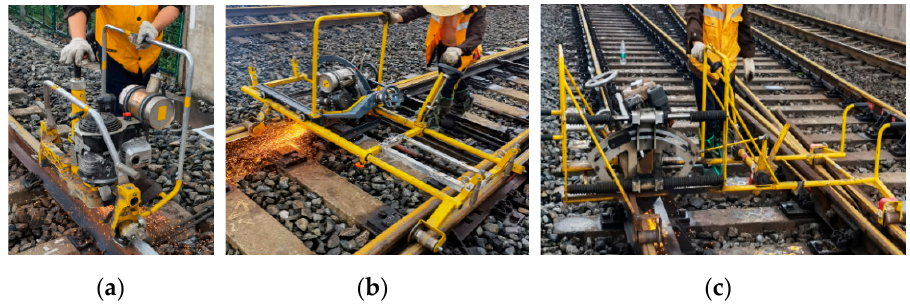
Figure 3. Small rail grinding machine: ( a ) copying grinder; ( b ) turnout grinder; ( c ) plane grinder. Because the grinding wheel wear leads to a concaved arc surface in the peripheral surface of the grinding wheel that matches to the contour of the rail surface, the